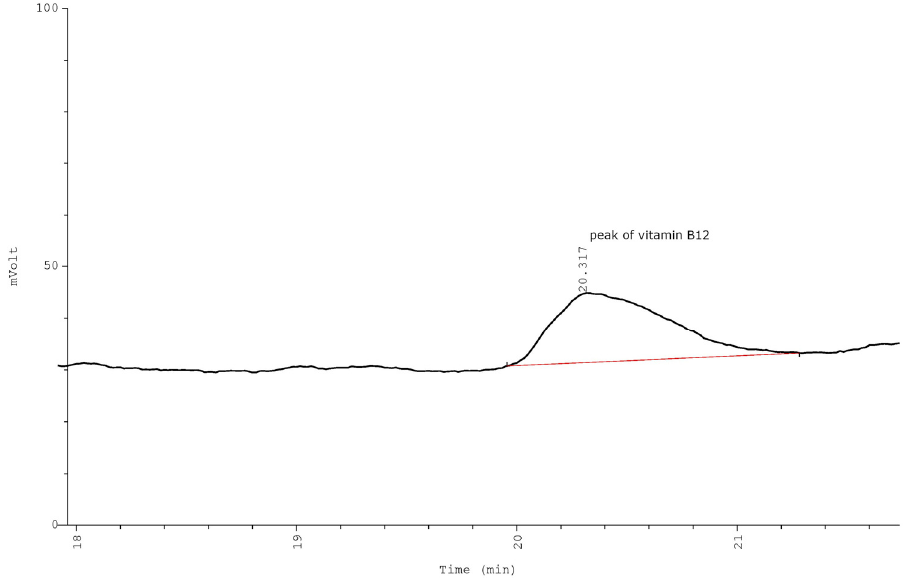
Figure 3. HPLC chromatogram obtained after the analysis of the pickled parsley juice sample.